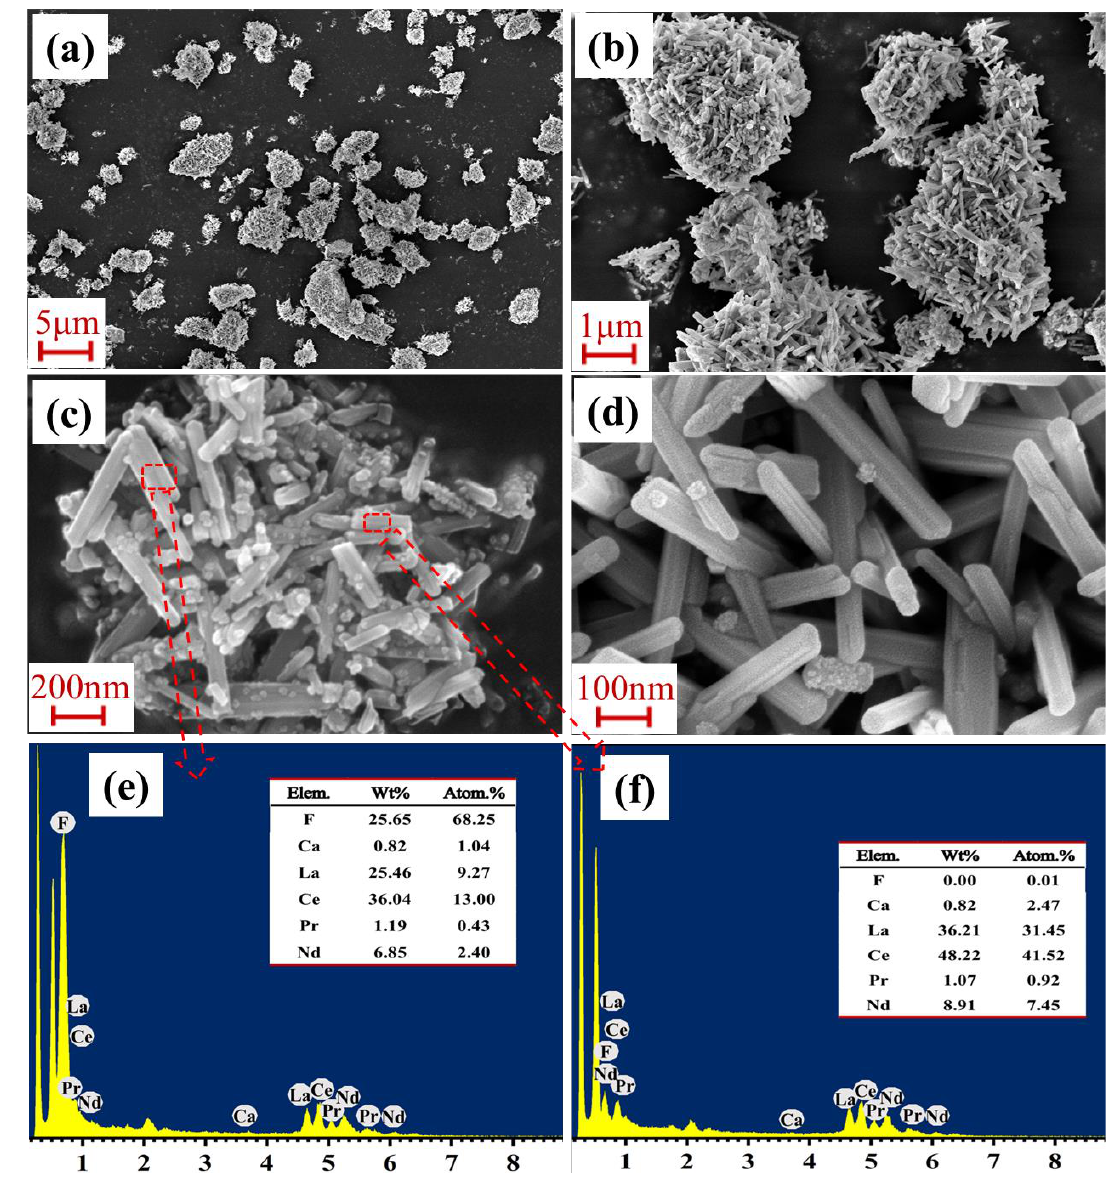
Figure 5. SEM images ( a – d ) and EDS analysis ( e , f ) results of alkali decomposition product under the conditions of 30% NaOH concentration and reaction duration of 4 h.